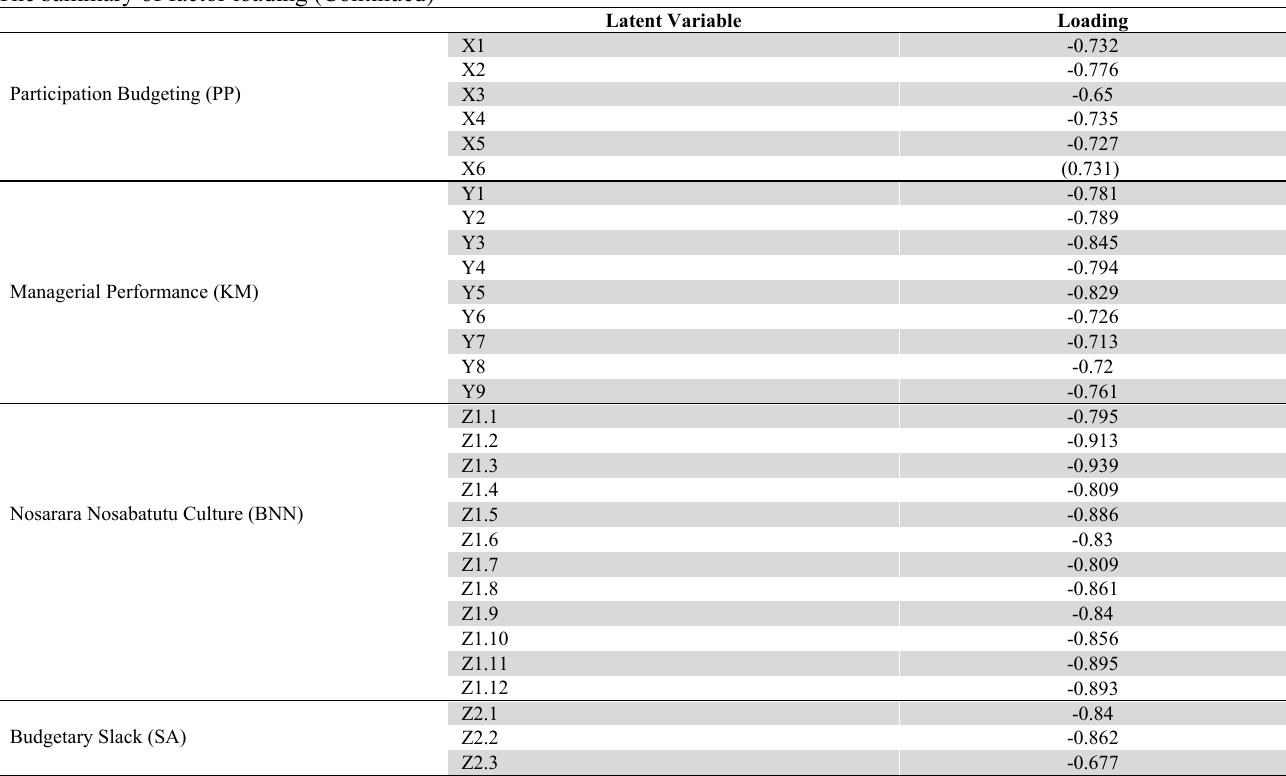
The summary of factor loading